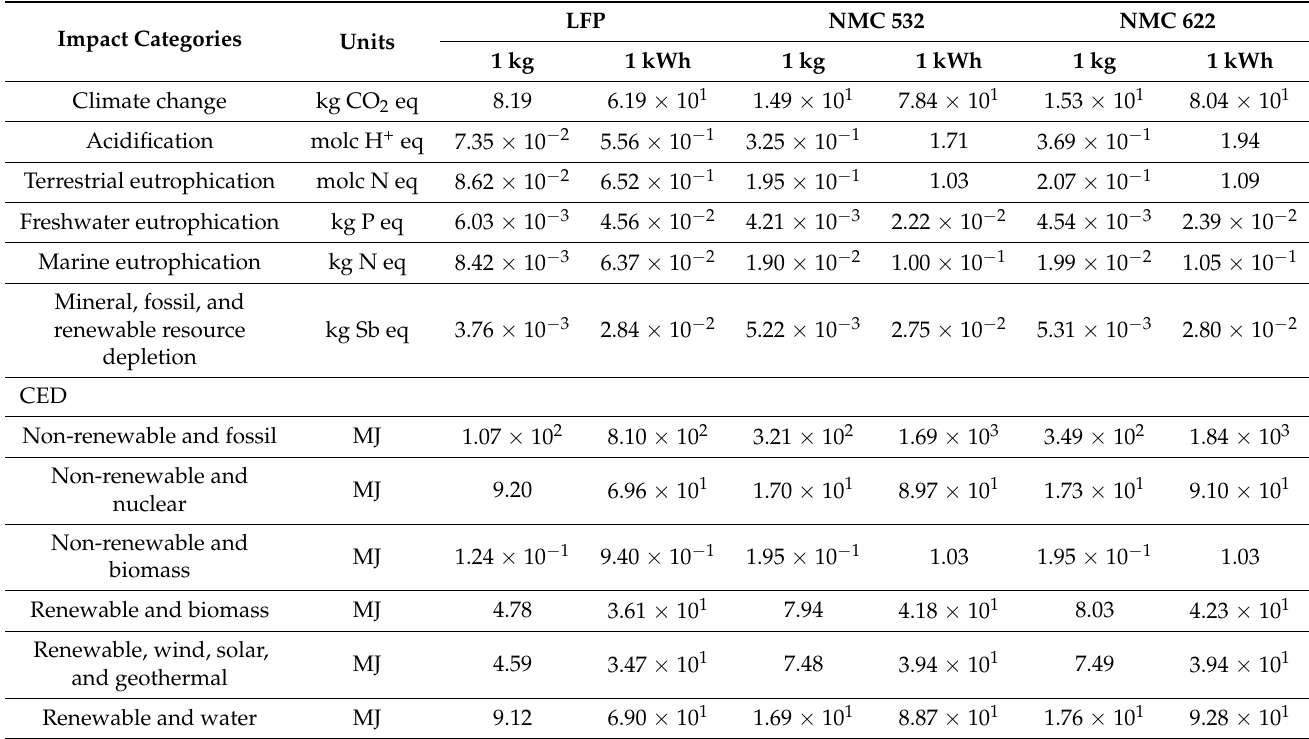
Table 2. Energy and environmental impacts of the battery cell’s life cycle. Data refer to 1 kg and 1 kWh of cell capacity. CED: cumulative energy